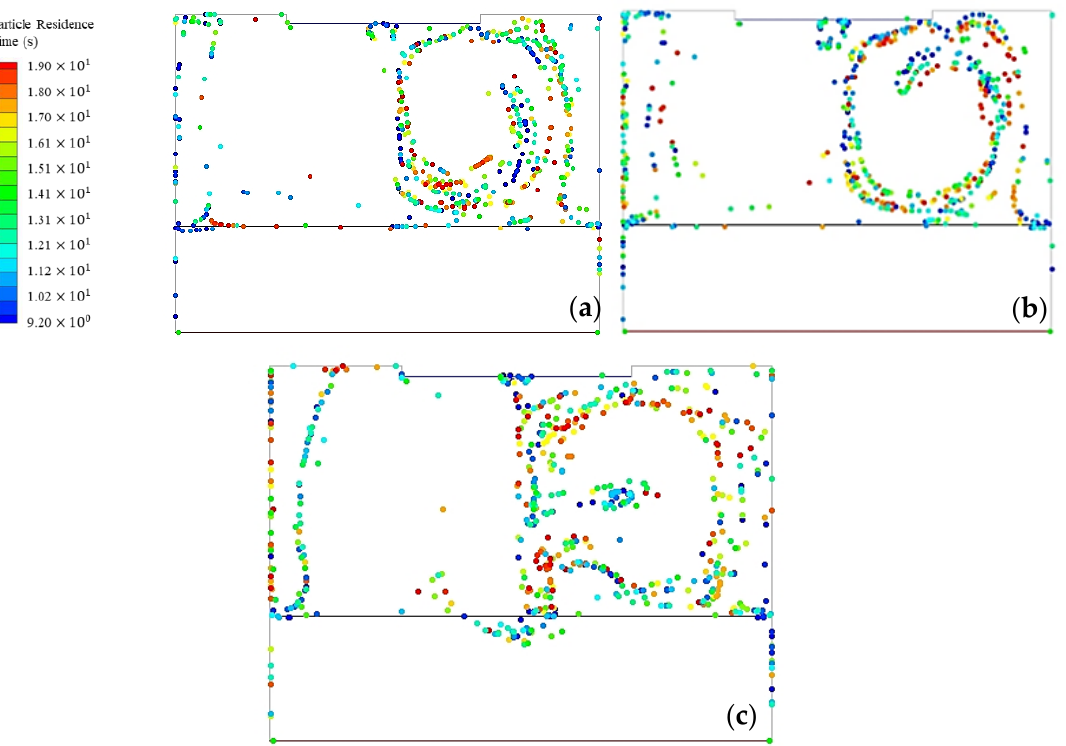
Figure 9. Inclusion distribution with different current ( a ) 1200 A ( b ) 1500 A and ( c ) 1800 A.